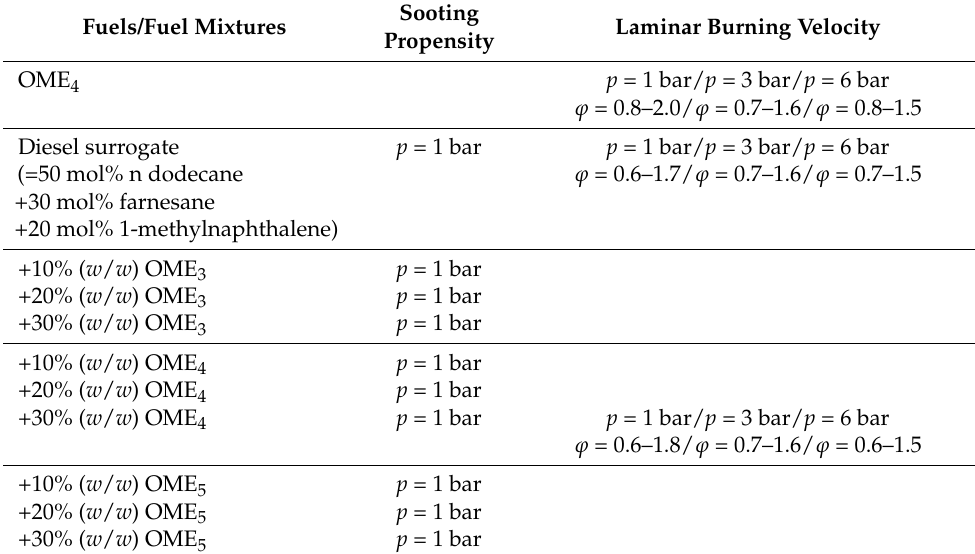
Table 2. Overview about the considered fuel mixtures and performed experiments at a preheat temperature each of T = 473